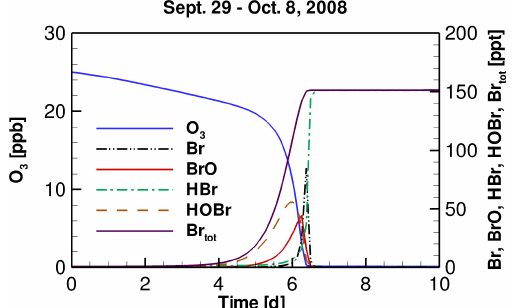
Figure 2. Temporal profiles of tropospheric ozone and major bromine species during the ODE from 29 September to 8 Octo- ber 2008.